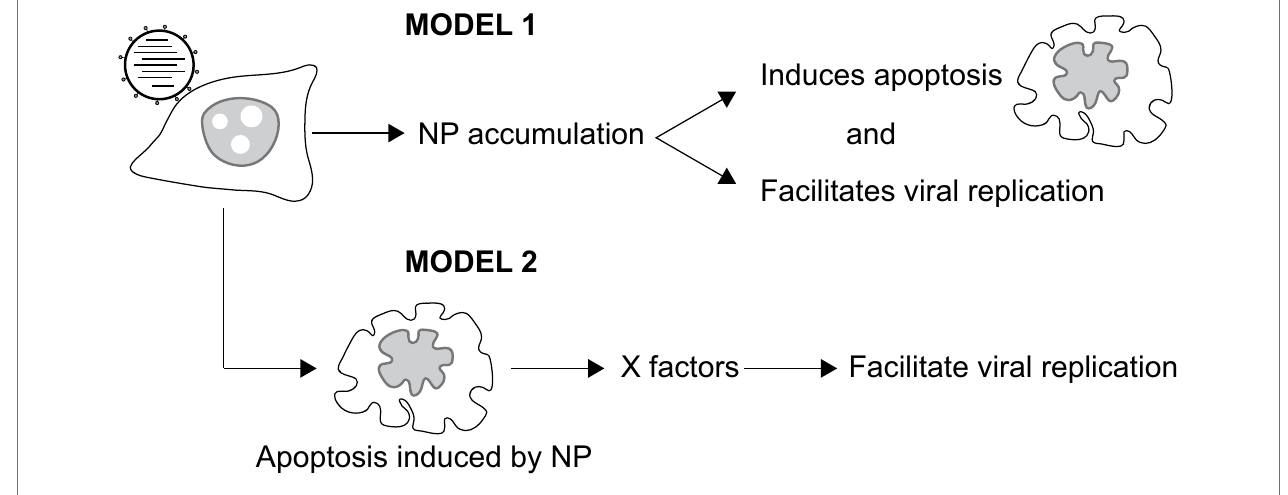
FIGURE 9 | Models illustrating the involvement of NP in apoptosis and vRNA replication. NP is known to induce both apoptosis and vRNA replication. Model 1 shows that the accumulation of NP may act to induce vRNA replication at a specific stage of apoptosis. Model 2 shows that cellular factors (X factors) expressed during apoptosis may act to facilitate vRNA